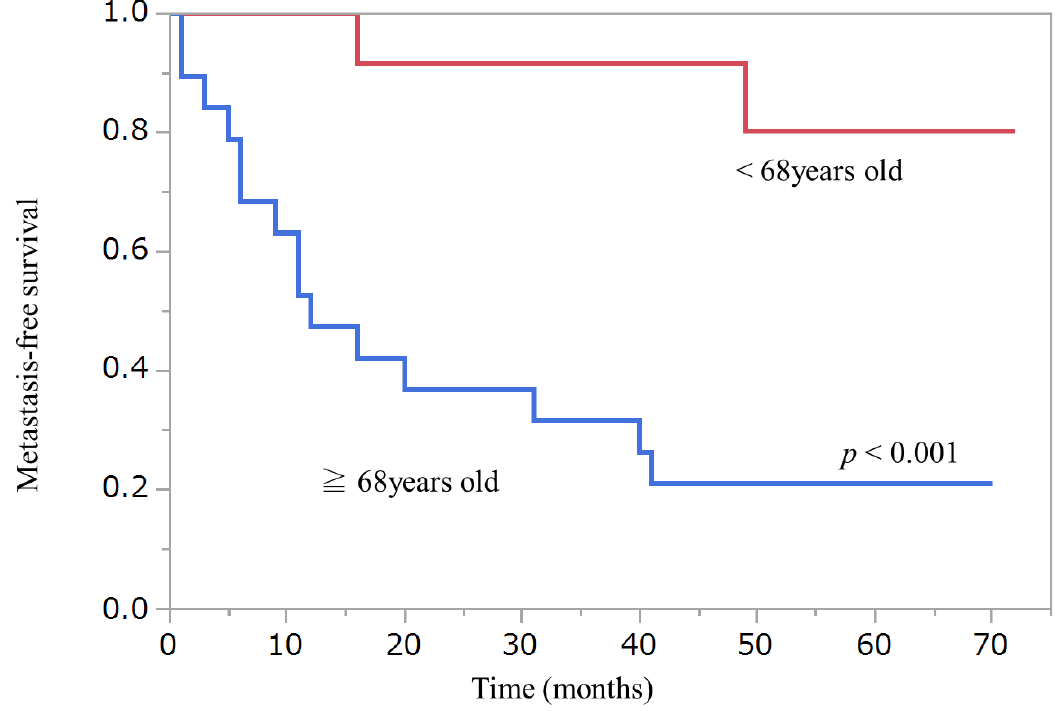
Figure 2. Kaplan–Meier curve and recurrence-free survival distribution between age and Figure 2. Kaplan – Meier curve and recurrence-free survival distribution between age and metasta- sis.